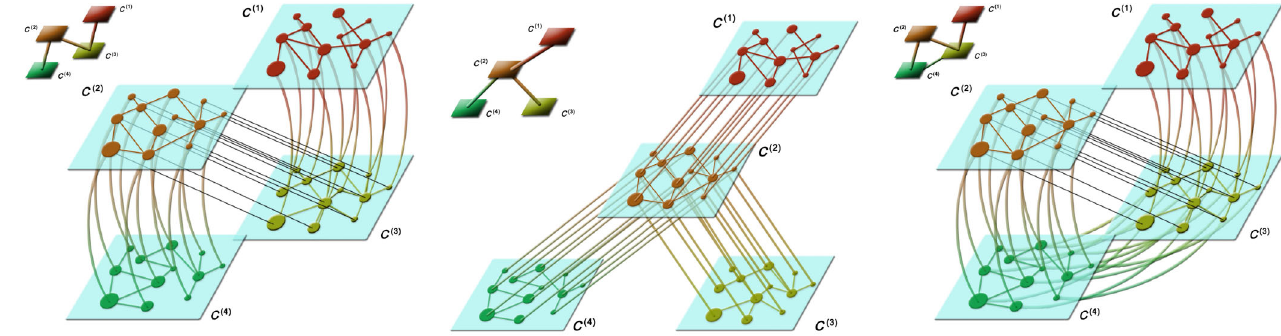
FIG. 2. Schematic of multilayer networks for three different topologies. We show three four-layer multiplex networks (and the corresponding network of layers as an inset in the top-left corners) and recall that each interlayer edge connects a node with one of its counterparts in another